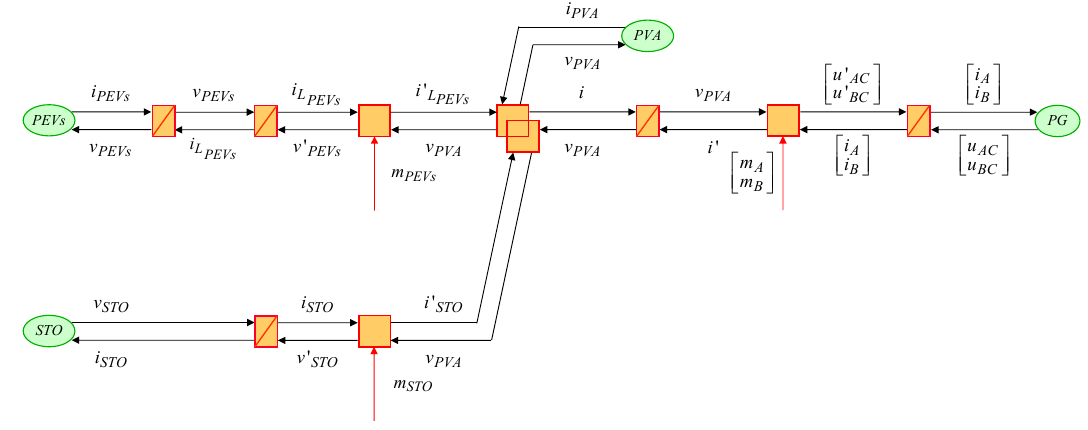
Figure 7. Energetic macroscopic representation of a DC microgrid for a PEV charging station.